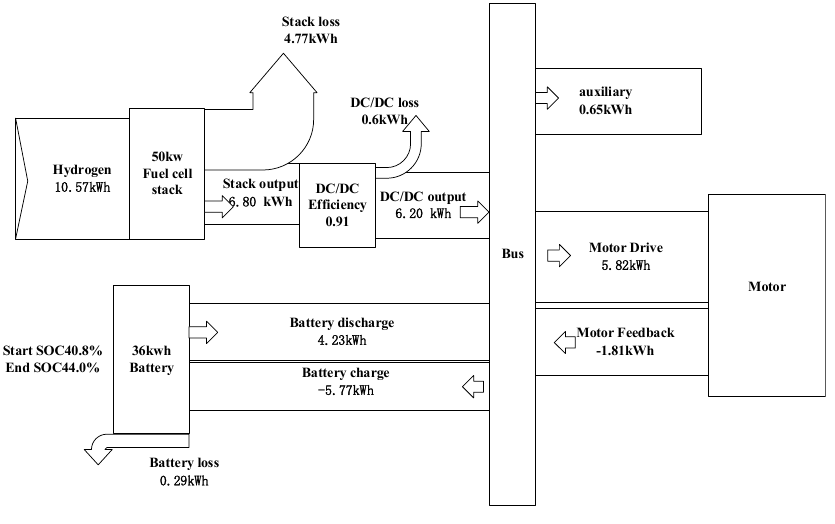
Figure 15. Sankey diagram.